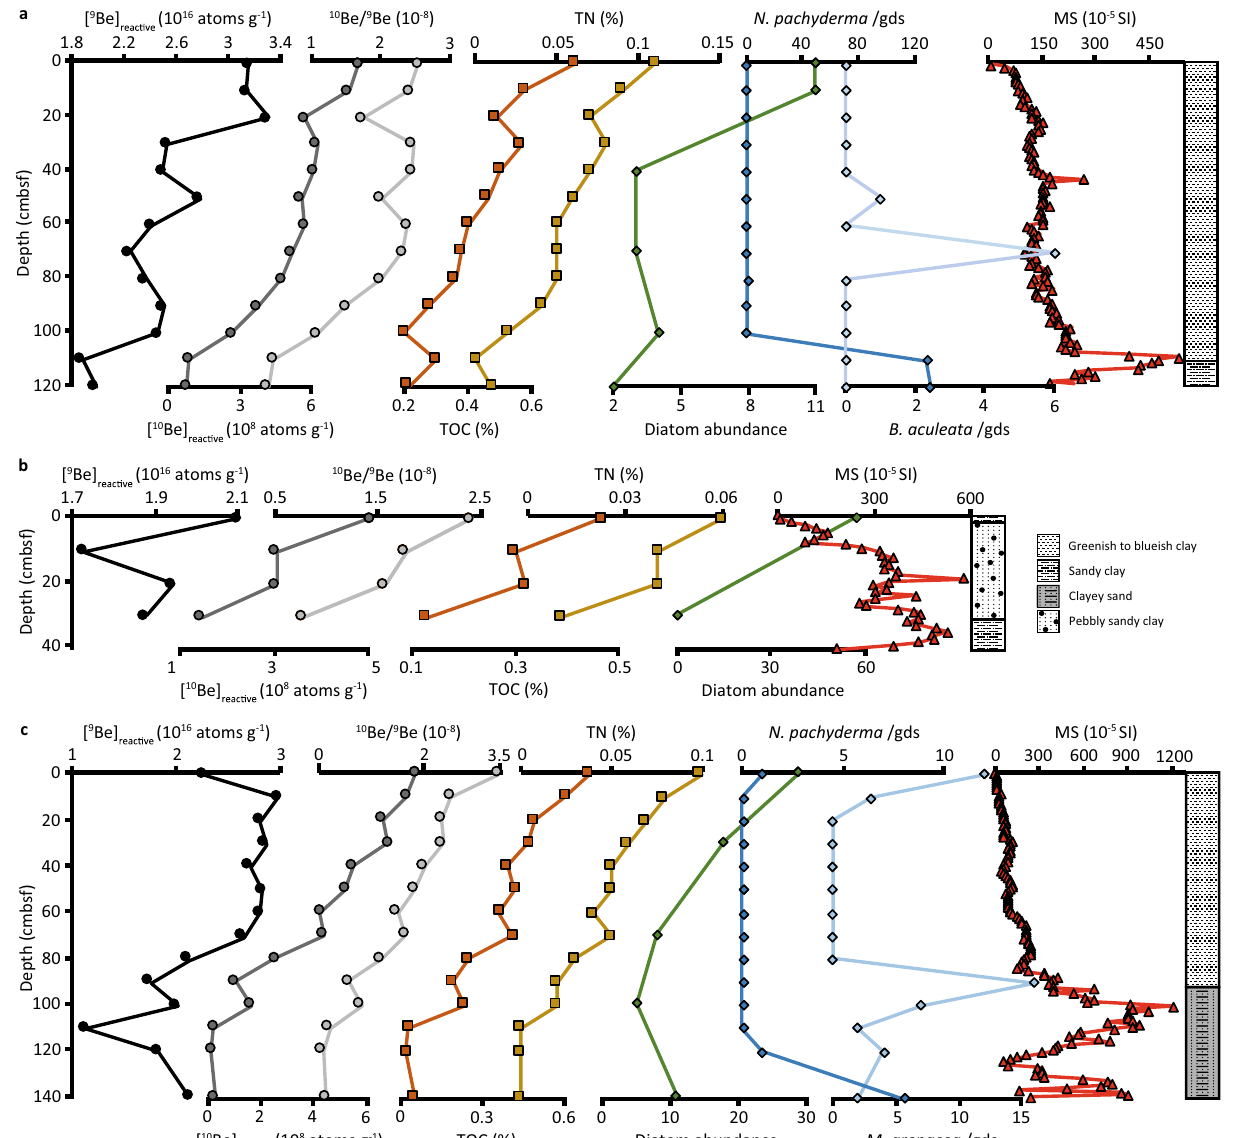
Fig. 2 Proxy data from Ferrero Bay. a – c The reactive 9 Be abundance, 10 Be abundance, and 10 Be/ 9 Be ratios (this study), alongside total nitrogen (TN), total organic carbon (TOC), diatom abundance, foraminifera taxa (counts per gram of dried sediment, gds), magnetic susceptibility (MS), and